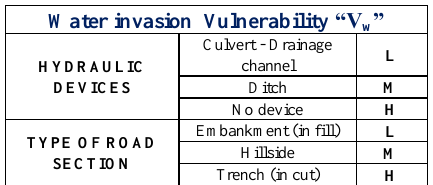
Table 2 . Classification of the elements that combine to